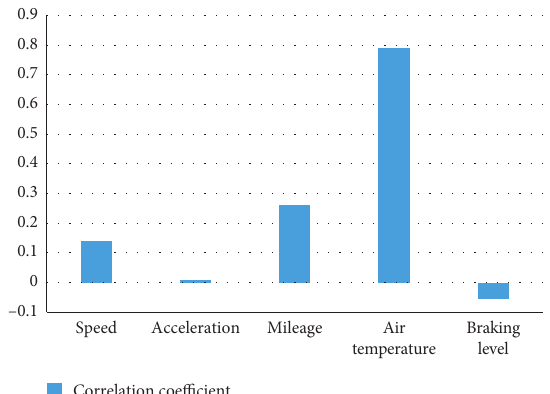
Figure 1: Correlation coefficient between gearbox temperature and train running state parameters.